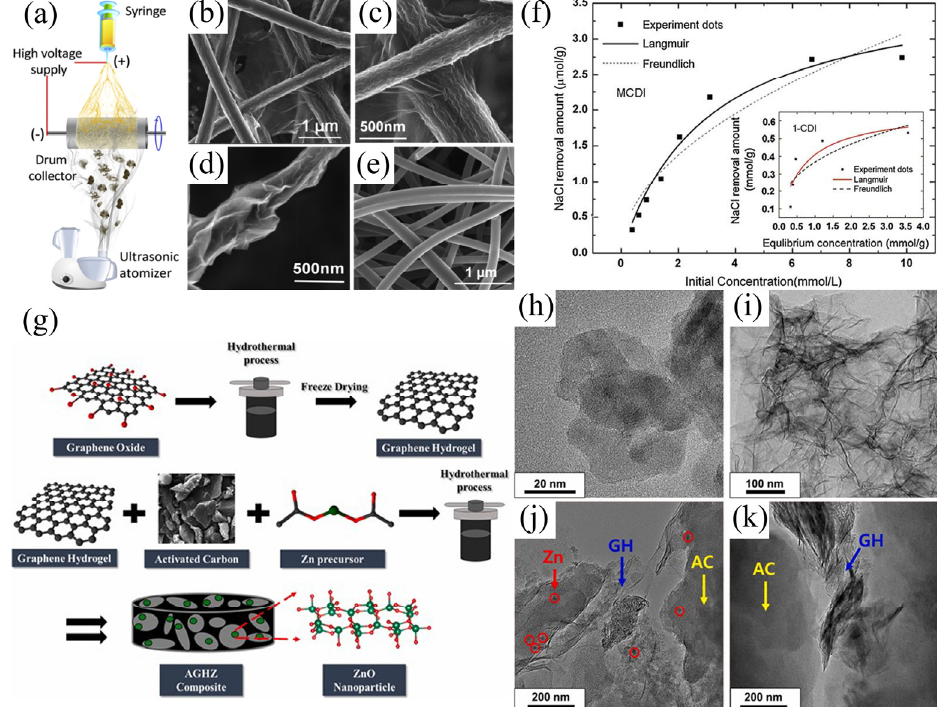
Figure 3. ( a ) The preparation illustrating diagram of electrostatic spinning and ultrasonic spraying